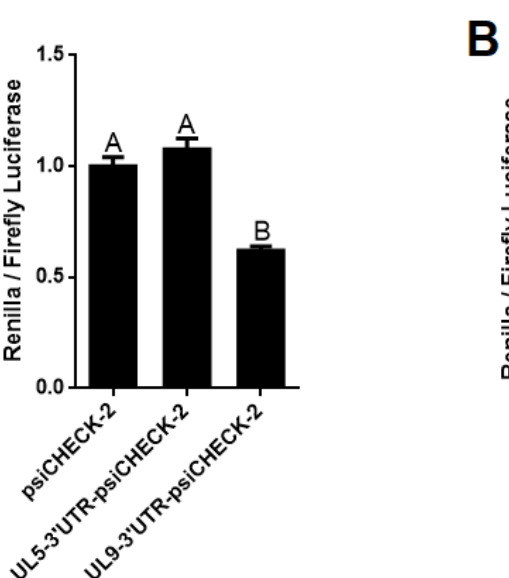
Figure 11. G 2 -PQSs from UL5-3 ′ UTR- and UL9-3 ′ UTR-regulated gene expression. ( A ) Dual-luciferase assay of G 2 -PQS from UL5 and UL9 in gene expression regulation. Different uppercase letters indicate the significant differences among the different constructs ( p < 0.05, Tukey’s honestly significant difference (HSD) test) ( B ) Dual-luciferase assay of G 2 -PQS from UL5 in gene expression regulation with the ligand NMM. ** p < 0.01, Student t -test.